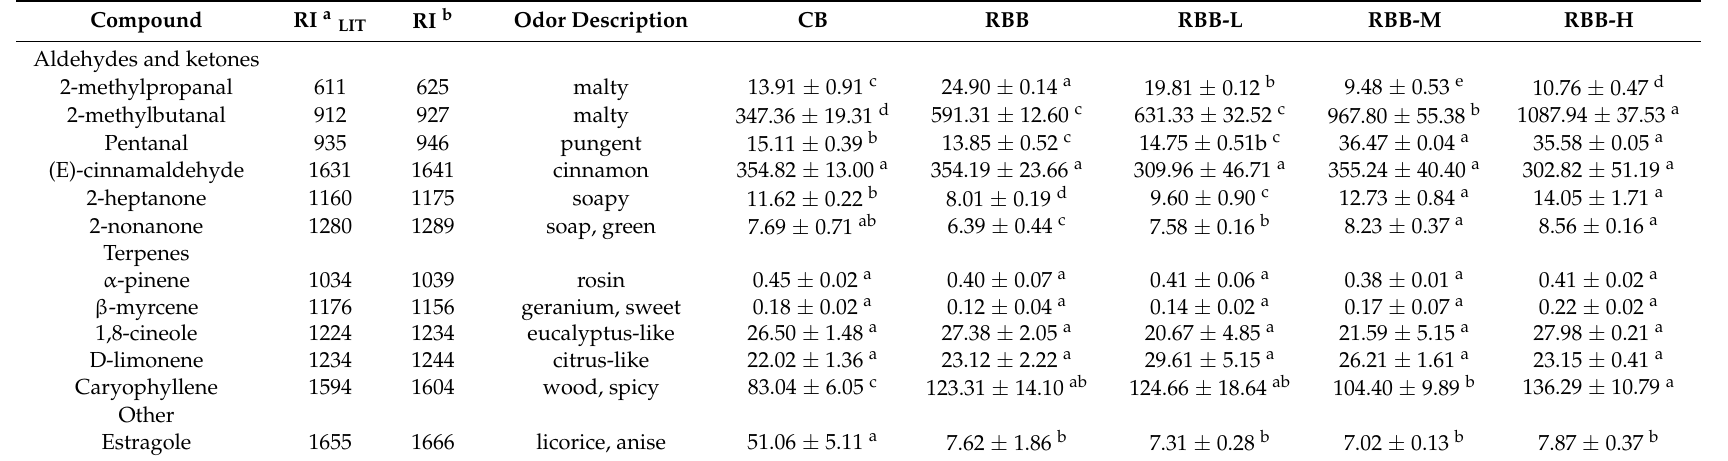
Table 2. Volatile compounds identified in control biscuits (CB), rye-buckwheat biscuits (RBB) and in biscuits with increasing rutin addition (RBB-L, RBB-M, RBB-H, respectively). The compounds were identified by comparing its mass spectrum and RI with data in the literature: tentative identification. Results are expressed as Peak Area × 10 6